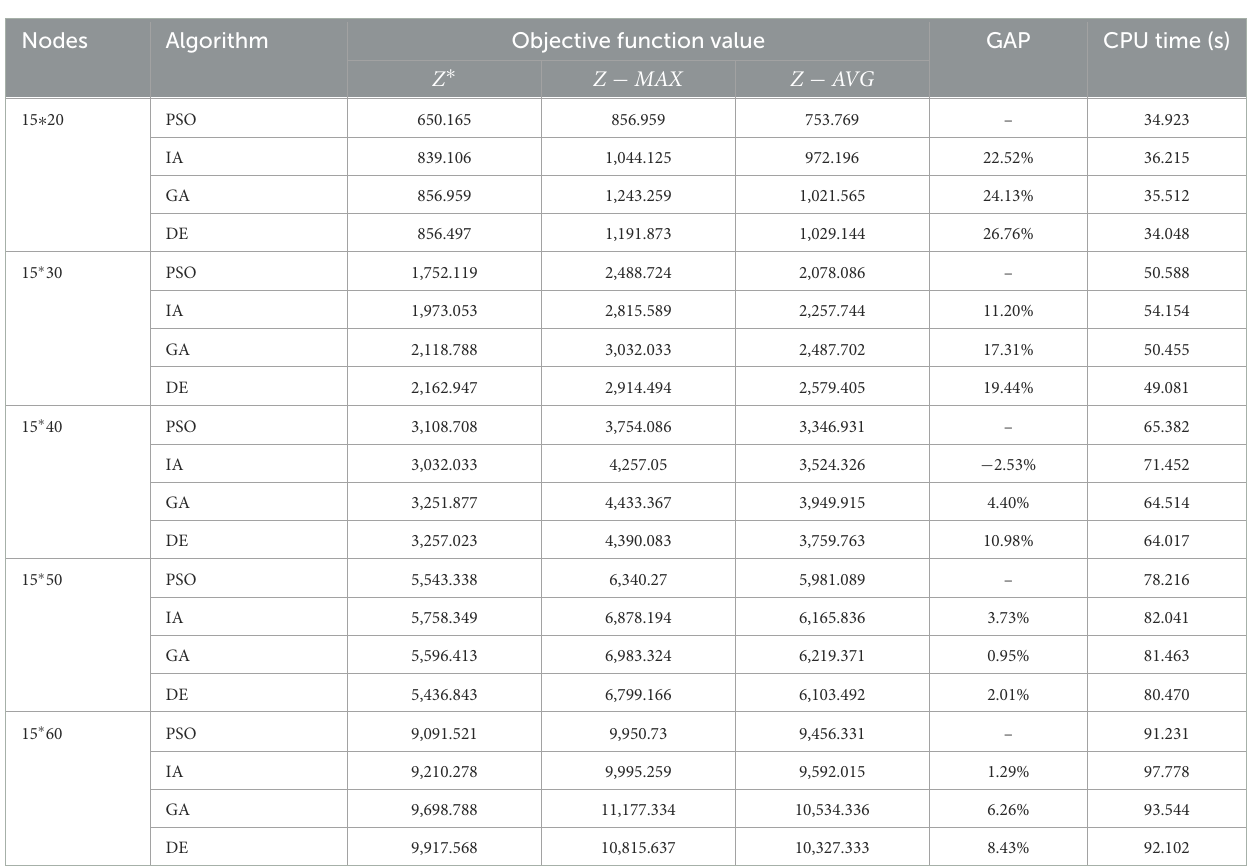
TABLE 7 Scale analysis of the group 2.